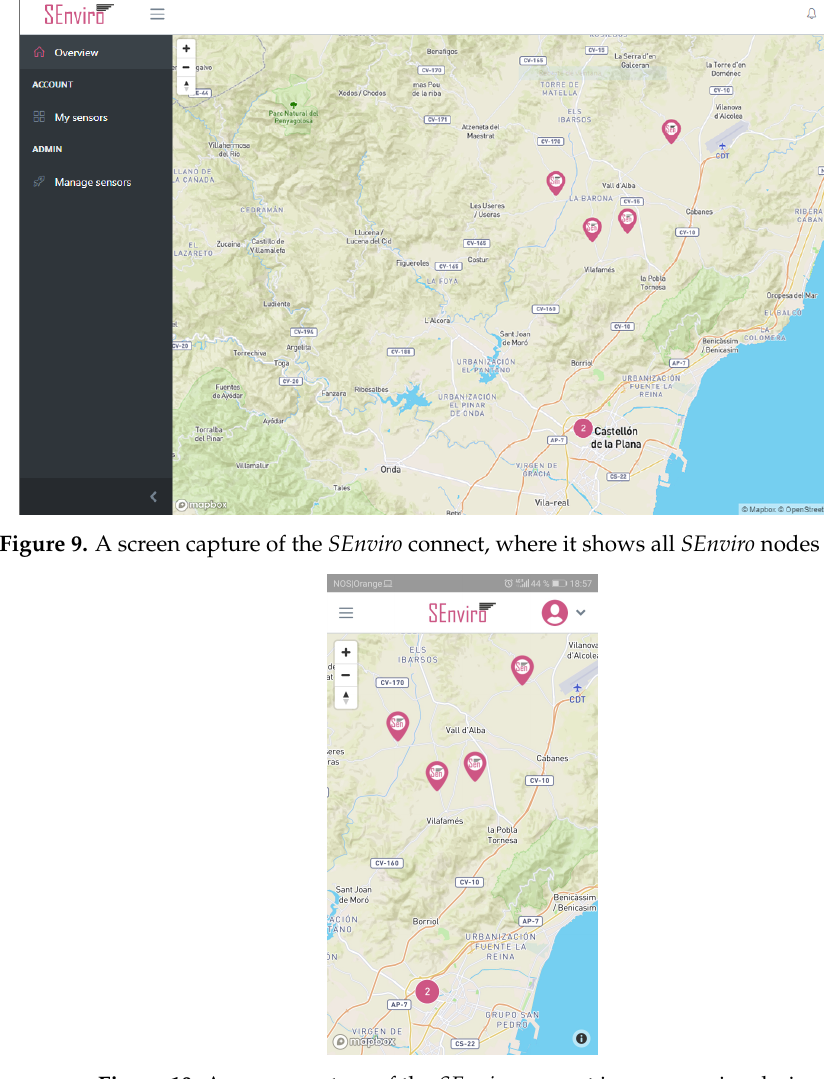
Figure 10. A screen capture of the SEnviro connect in a responsive